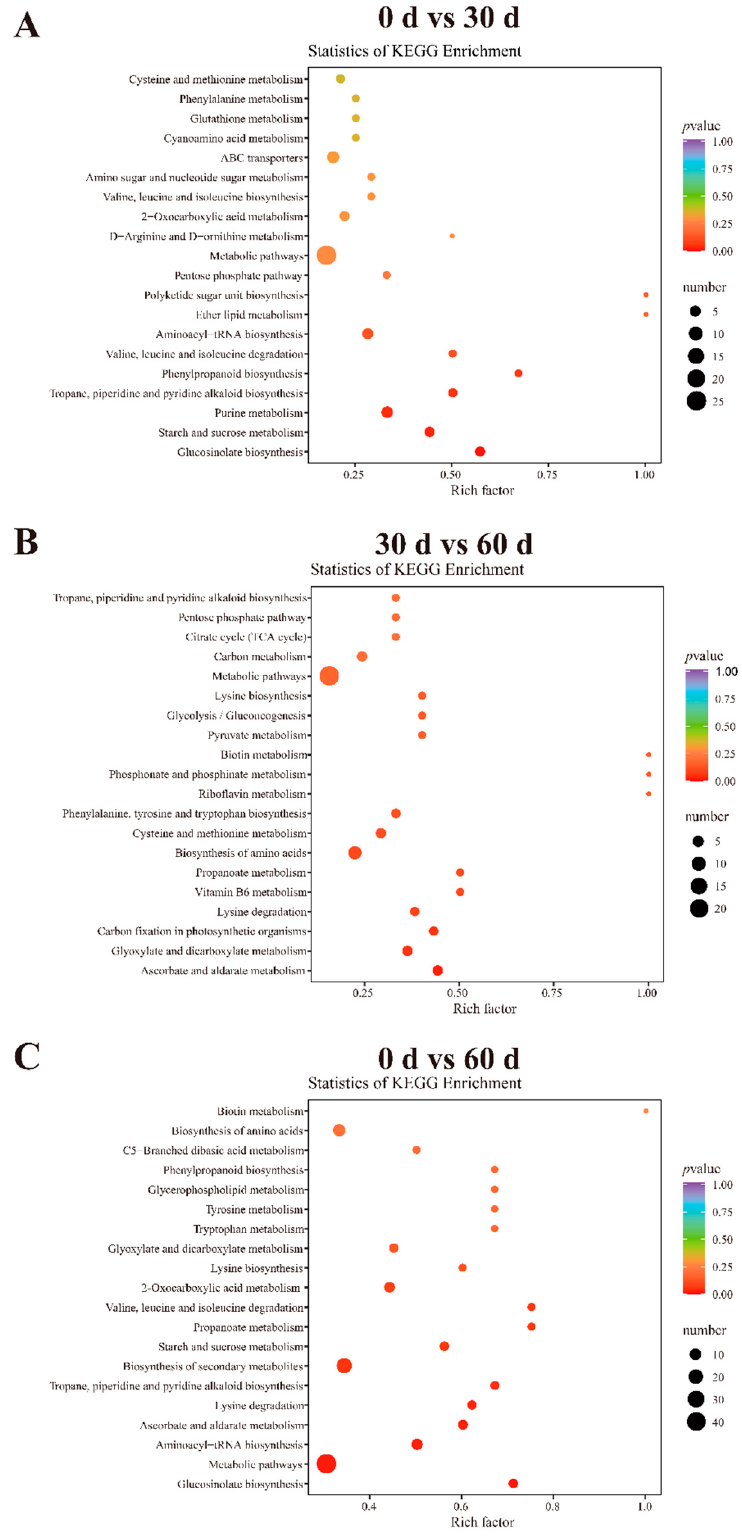
Figure 6. KEGG enrichment in ‘Fengtang’ plum fruits at different storage periods: ( A ) 0 d vs. 30 d, ( B ) 30 d vs. 60 d, and ( C ) 0 d vs. 60 d.